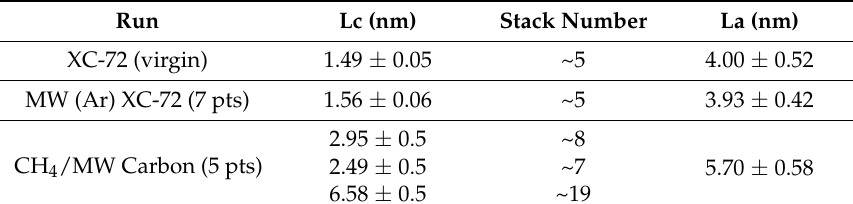
Table 1. XRD analysis of carbon black.